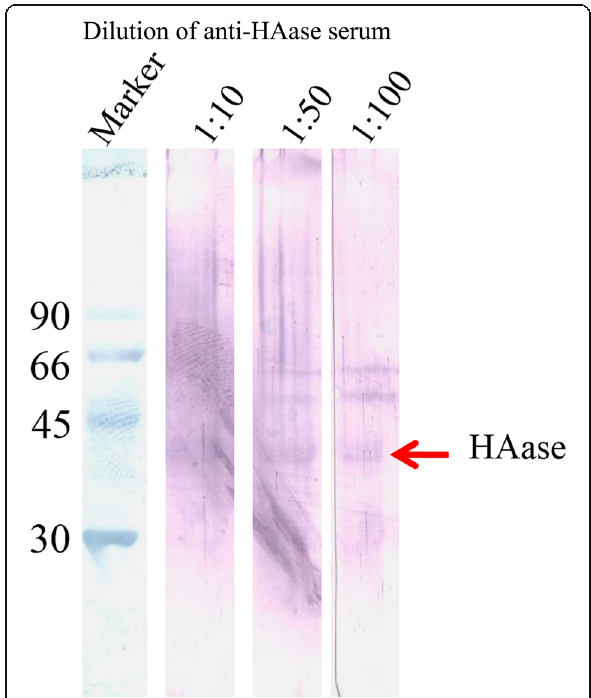
Fig. 9 Western immunoblotting analysis of venom HAase with an anti-HAase serum. Lane 1: molecular weight marker. Lanes 2 – 4: HAase was incubated with different dilutions of anti-HAase serum. Venom HAase is indicated by the arrow